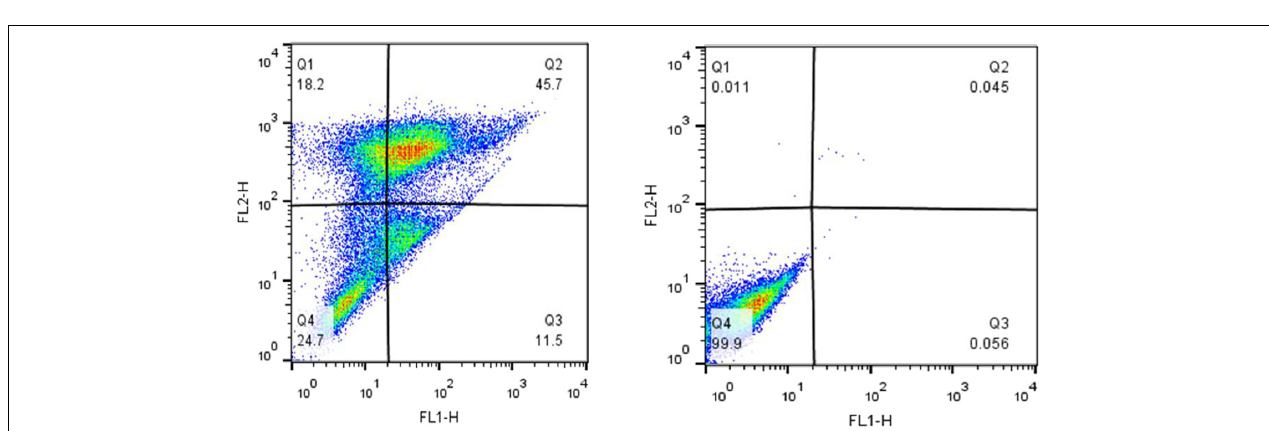
FIGURE 5 | The impact of tamoxifen on apoptosis of MCF-7 cancer cells. Quadrants were drawn based on FSC/SSC plot in the untreated cells. Percent apoptosis was determined using two dimensional plot of PI (PI, Y -axis) and Annexin V-FITC ( X -axis). (Left) Treated cells with a single dose of tamoxifen (250 µ M), and (Right) the untreated control. Different cellular distributions are shown in the quadrants, Q1, necrotic cells; Q2, late apoptotic cells; Q3, early apoptotic cells; and Q4, normal